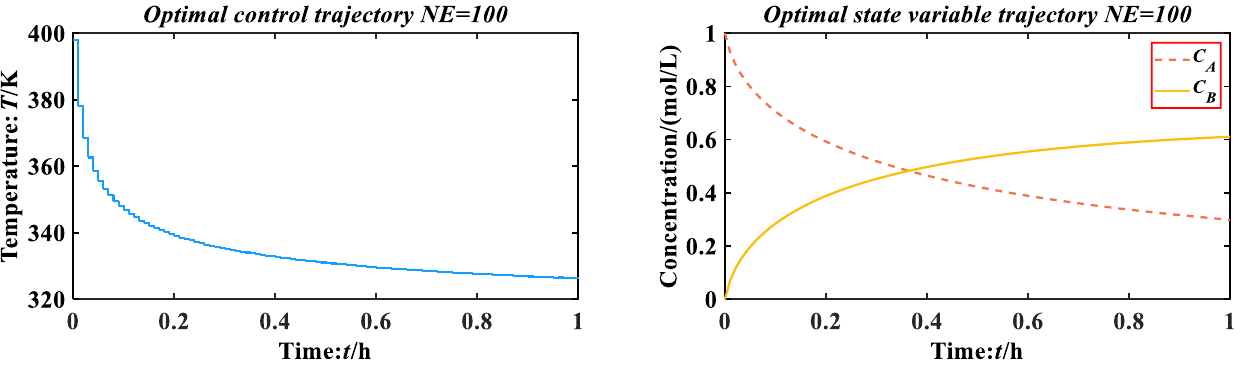
Figure 21. CM-HSSA for Problem 1.